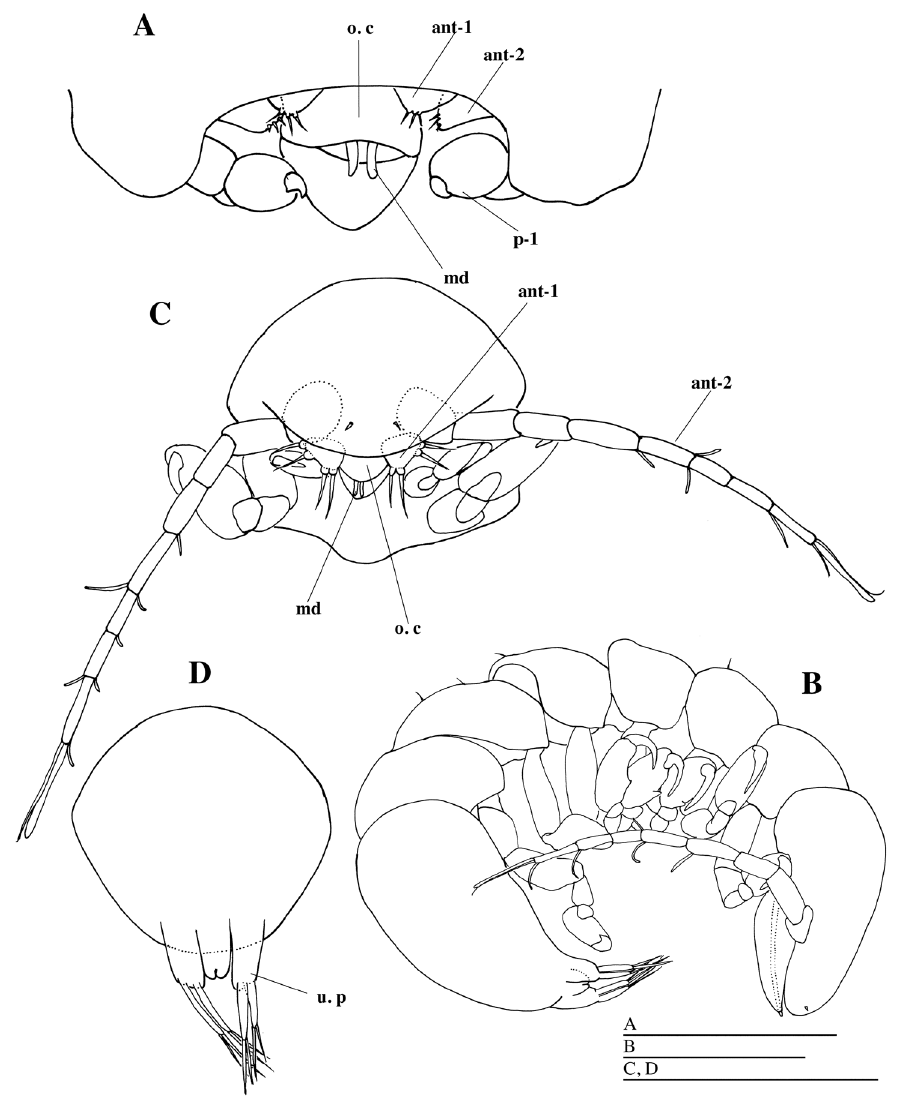
Figure 3. Aspidophryxus izuensis sp. n., A holotype female B–D allotype male (KMNH IvR 500911): A cephalon, ventral B habitus, lateral C cephalon and first and second pereomeres, ventral D pleotelson, dorsal. Scale bars 100 µm. Abbreviations: ant-1, antennule; ant-2, antenna; o. c, coral cone; md, mandi- ble; u. p,